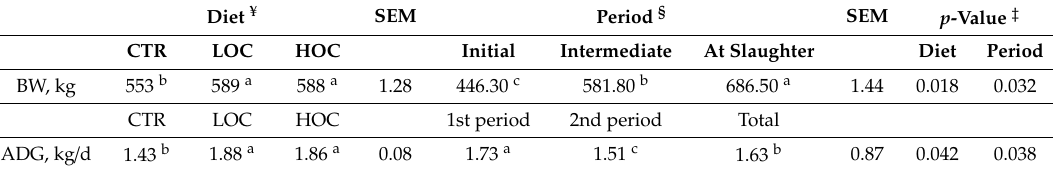
Table 4. E ff ect of dietary olive cake supplementation on in vivo performance of Limousin young bull during the